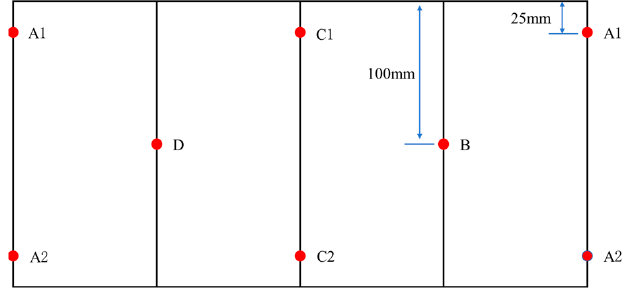
Figure 4. Diagram of acoustic emission probe arrangement.